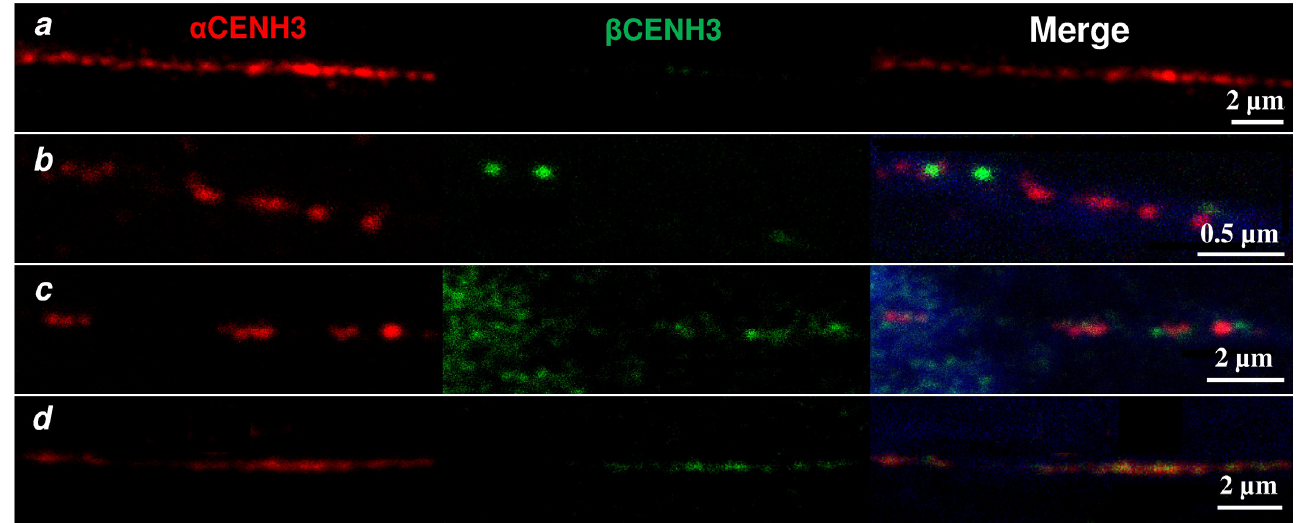
Figure 7. Different types of nucleosome clusters visible on extended chromatin fibers. ( a ) Clusters containing nucleosomes with α CENH3 -only signals. ( b ) Clusters containing nucleosomes with β CENH3 -only signals. ( c , d ) Examples of clusters containing nucleosomes with α CENH3 and β CENH3 signals colocalized. The colocalization values are: c = β CENH3 / α CENH3 —25–75%, α CENH3 / β CENH3 —25–35%; d = β CENH3 / α CENH3 —56–90%, α CENH3 / β CENH3 —22–62%. Clusters with CENH3 signals are interrupted by gaps with nucleosomes containing the canonical histone H3.